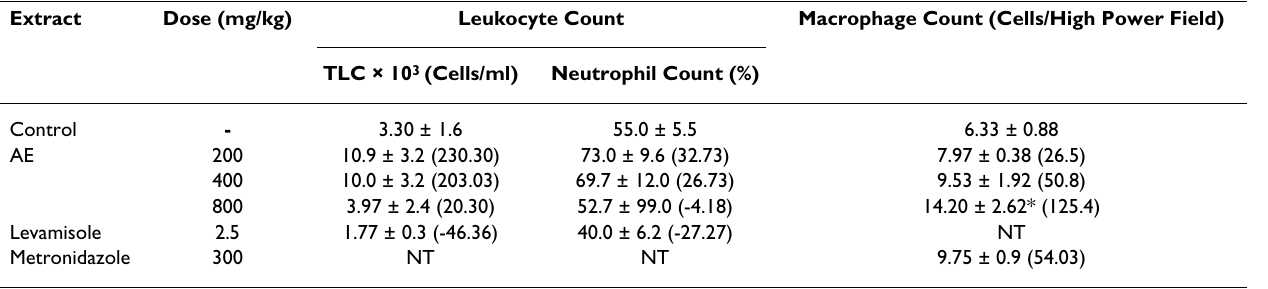
Table 7: Effect of extract on leukocyte and macrophage migration in vivo Extract Dose (mg/kg)